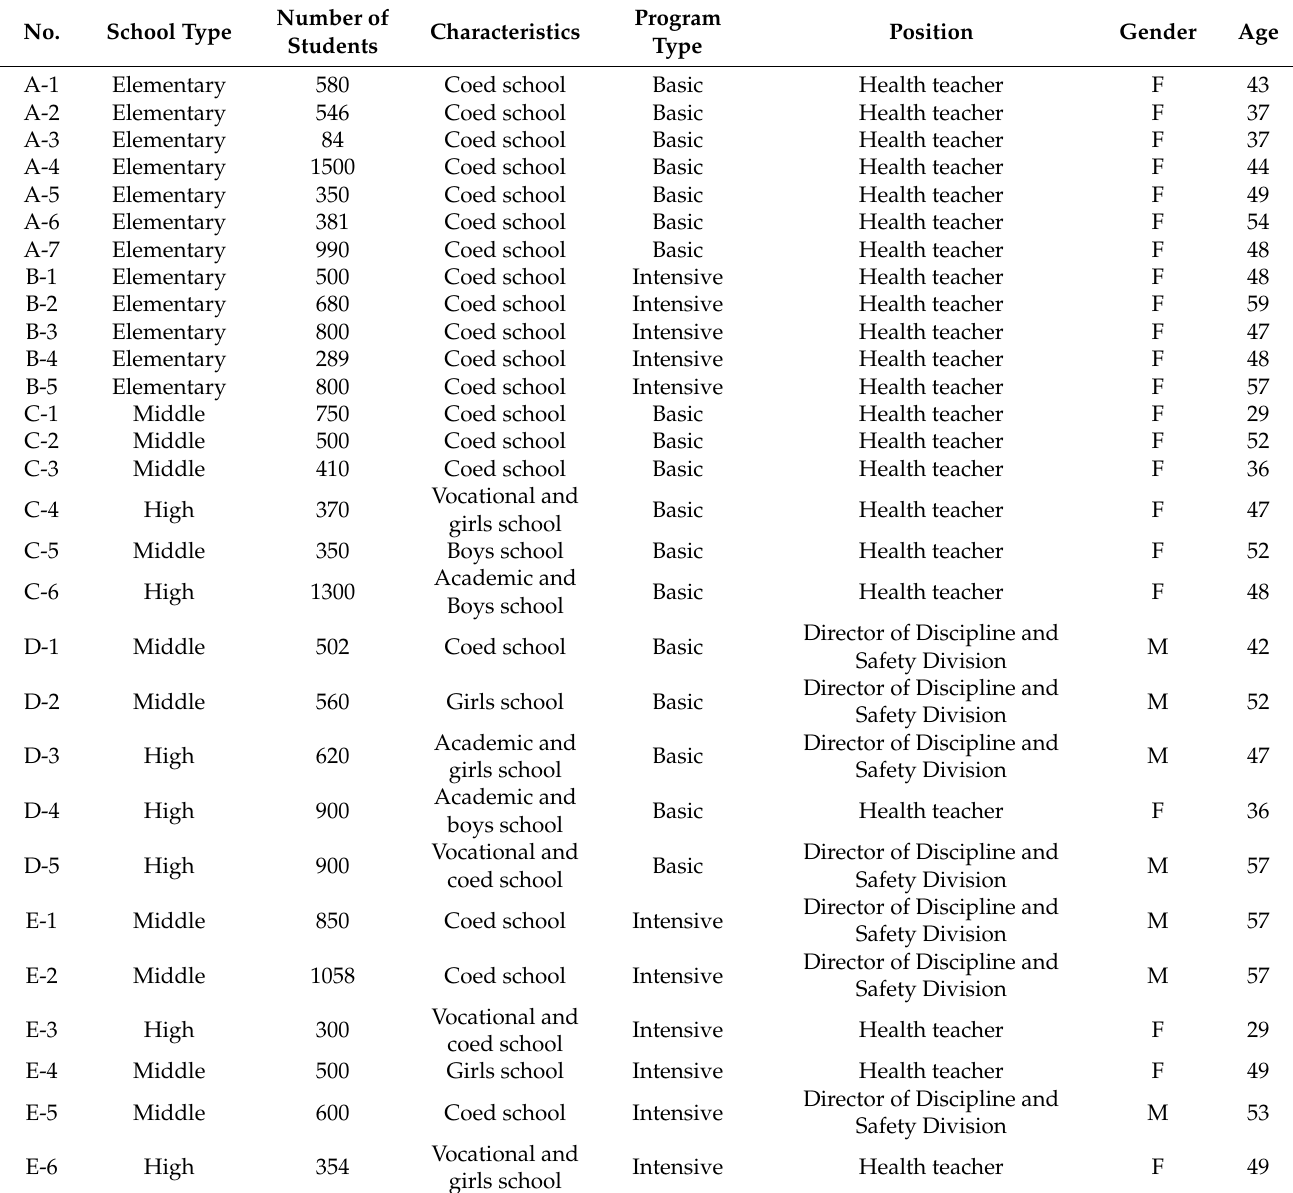
Table 3. Characteristics of study participants ( N =